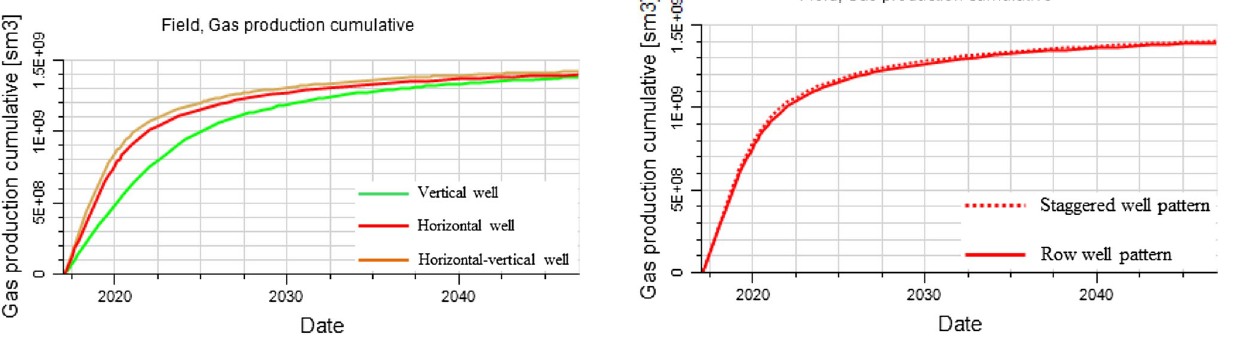
Fig. 6 Demonstration of well type—the cumulative gas production curve of the sweet spot